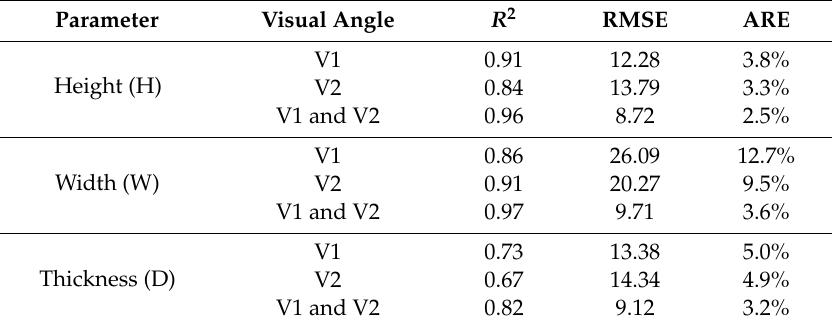
Table 1. Relationship between calculated and measured values of morphology for sample fruit